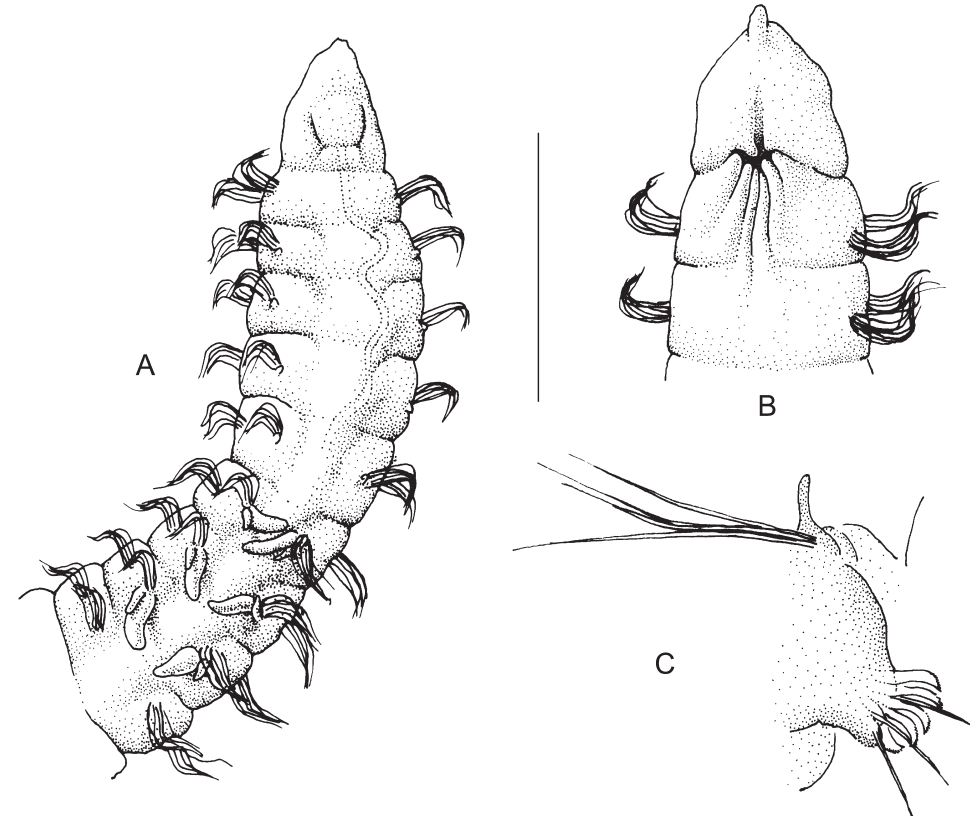
Fig . 2. – Levinsenia flava : A, anterior region, dorsal view; b, anterior region, ventral view; c, parapodium chaetiger 26. Scale bar: A 360 µ m; b 100 µ m; c 295 µ